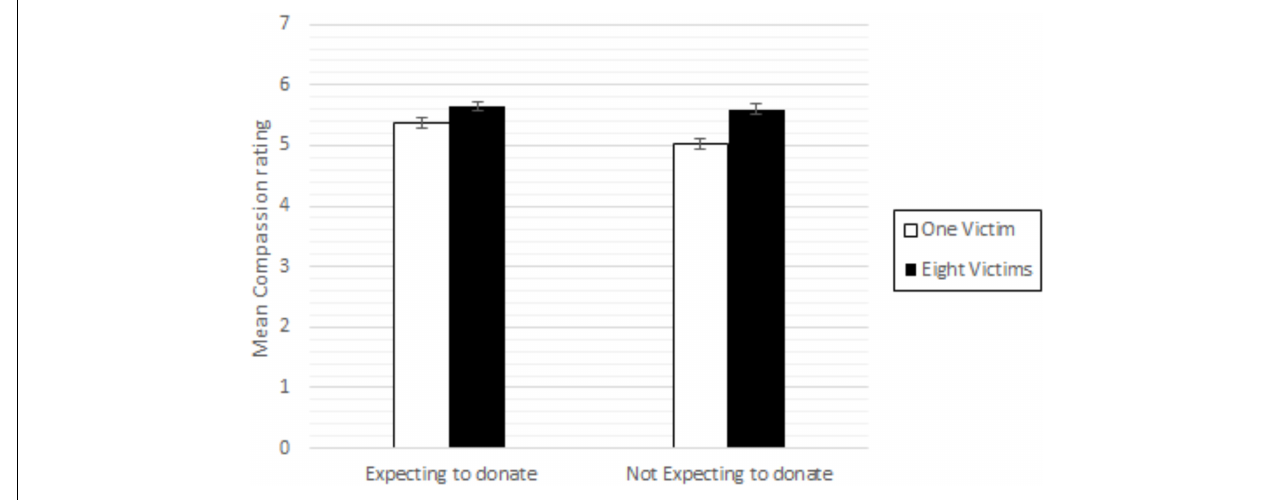
FIGURE 3 | Mean compassion toward the child (children) across conditions (higher number indicates more compassion). Error bars are